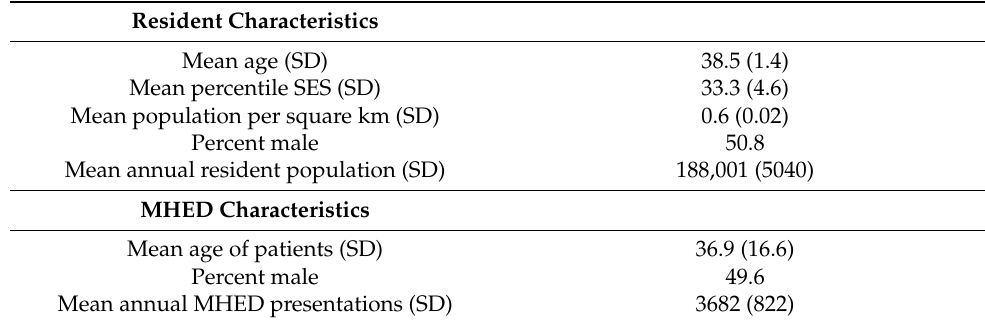
Table 1. Characteristics of the Wheat Belt population from 1 January 2002 to 30 June 2017.